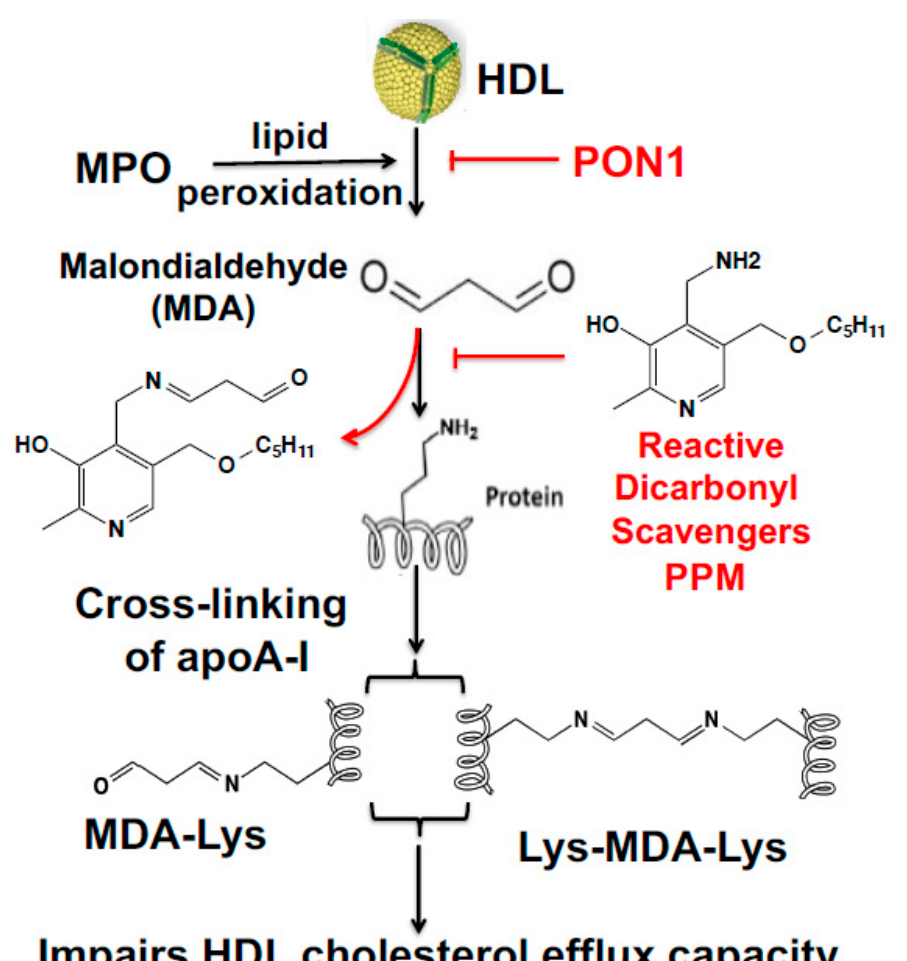
Figure 1. Mechanism of malondialdehyde (MDA) formation from peroxidation of high-density lipoproteins (HDL), its subsequent crosslinking of proteins and effects of reactive dicarbonyl scavenging on HDL cholesterol efflux capacity and anti-inflammatory functions.